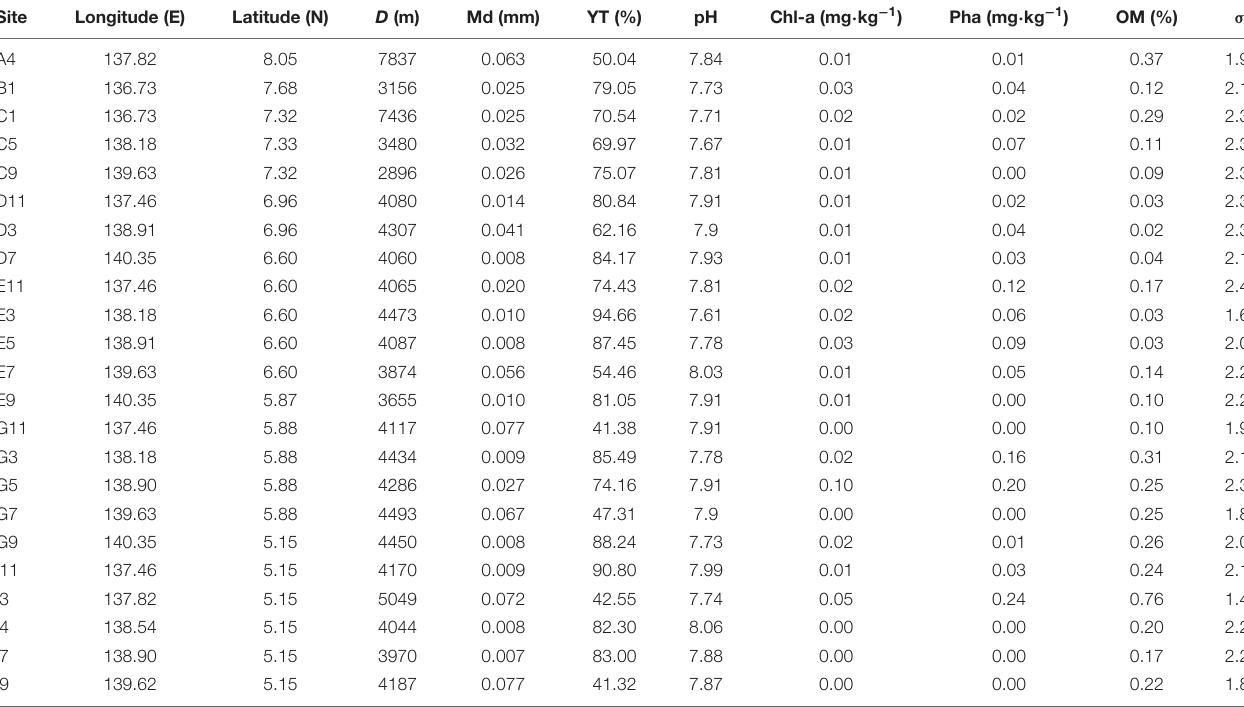
TABLE 1 | Environmental variables at the sampling site near the Yap trench of the Western Pacific